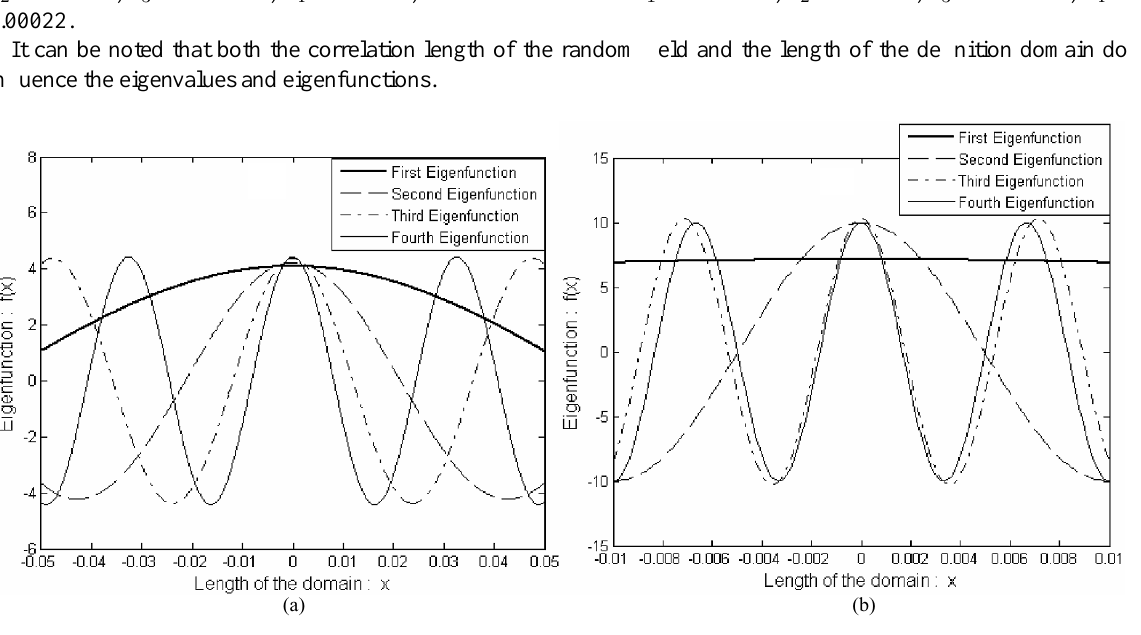
Fig. 2. Graphs of the first four eigenfunctions of the covariance function: (a) L co r,x = 0 . 05 m and Ω x = [ − 0 . 05 , 0 . 05] ; (b) L co r,x = 0 . 01 m and Ω x = [ − 0 . 01 , 0 . 01]